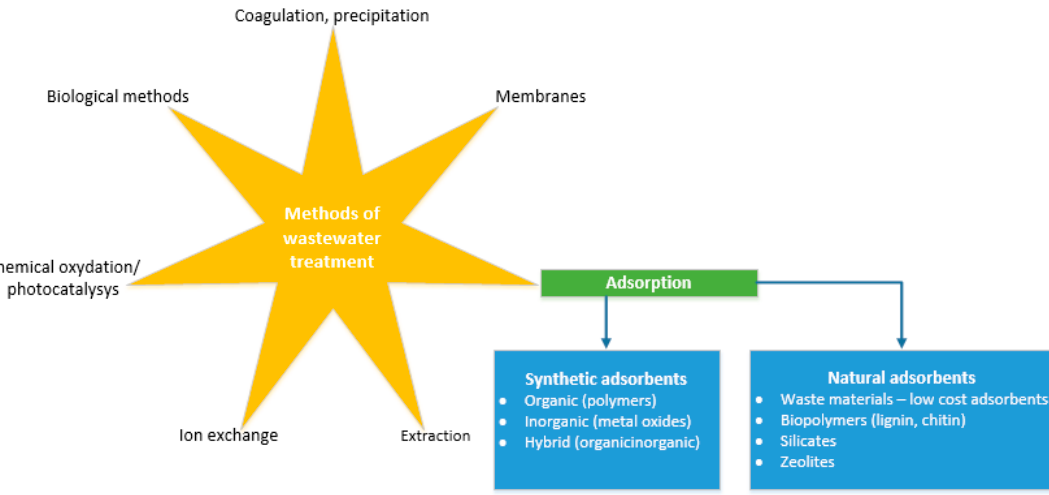
Figure 2. Methods of wastewater treatment.